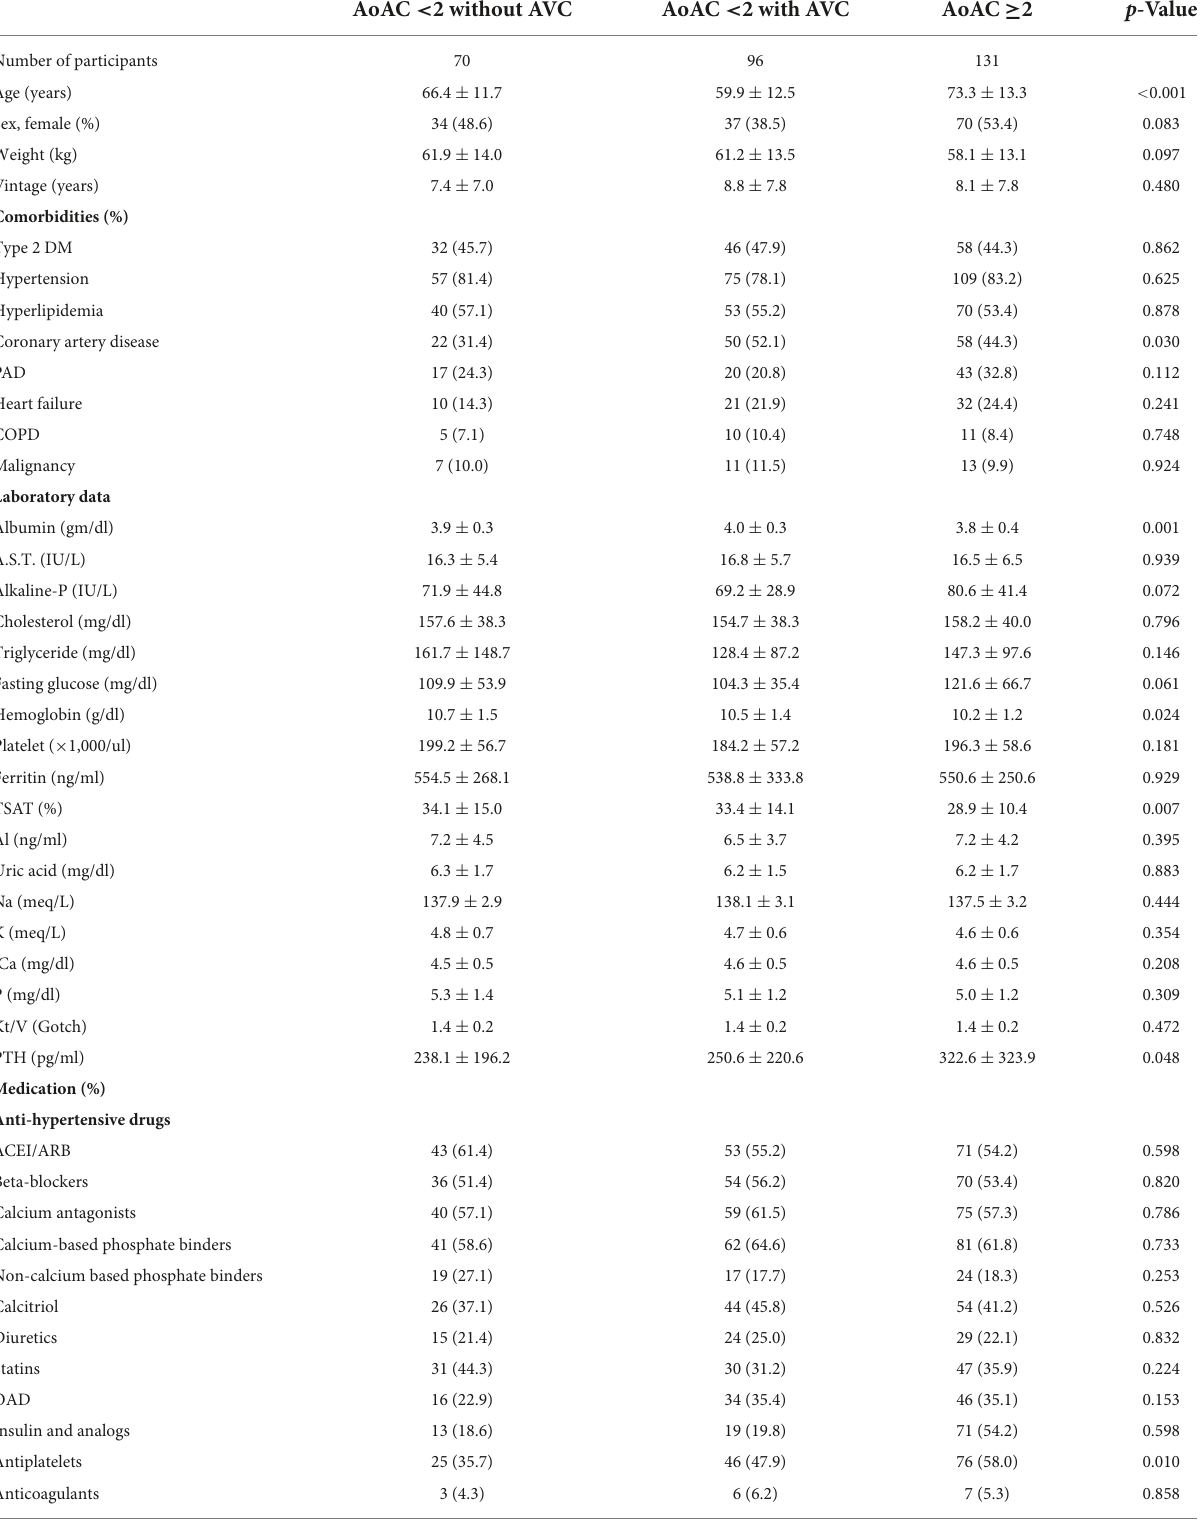
TABLE 1 Baseline characteristics of patients on MHD based on the severity of AoAC and the presence of AVC. AoAC < 2 without AVC AoAC < 2 with